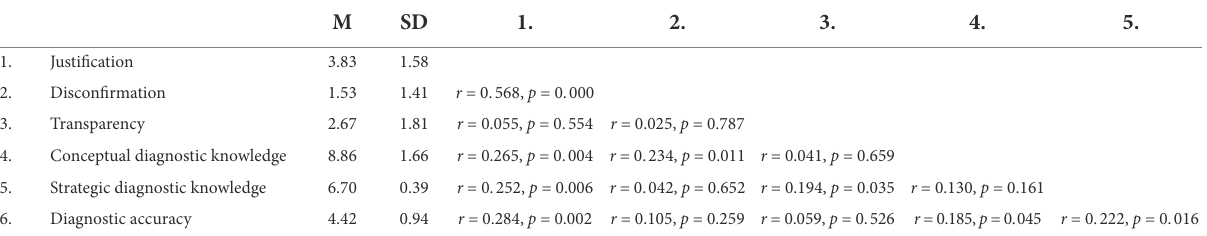
TABLE 3 Descriptive results and Pearson correlations of preservice teachers’ scores for the three argumentation facets justification, disconfirmation, and transparency, as well as conceptual and strategic diagnostic knowledge and diagnostic accuracy.